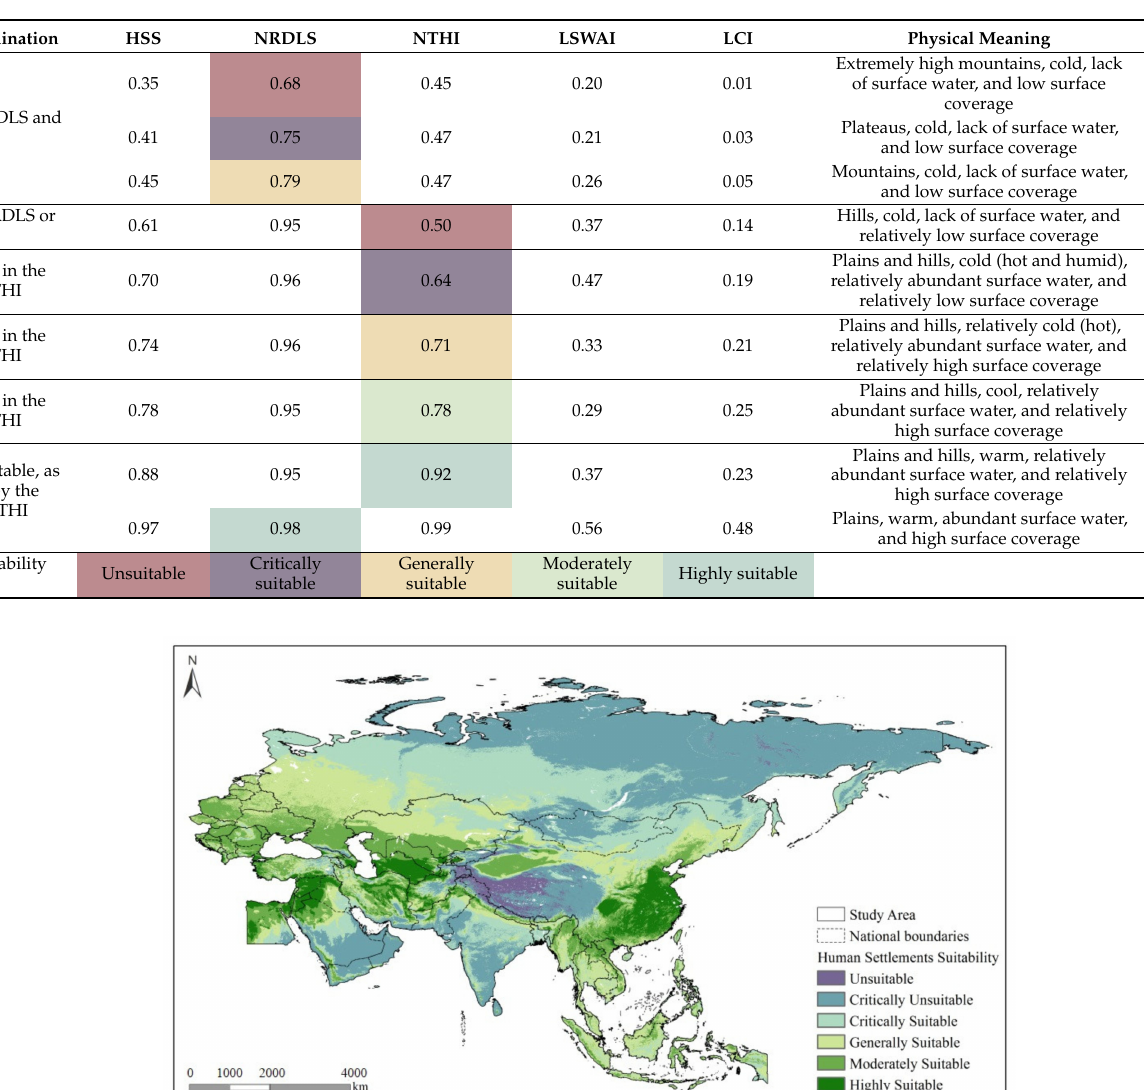
Table 3. Correlation coefficient matrix of single factors for the HSS.